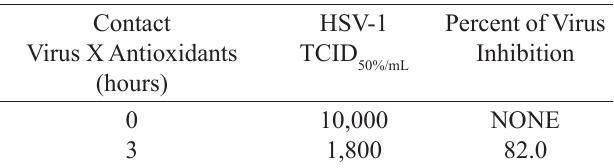
TABLE I – Viral inhibition action of natural antioxidant